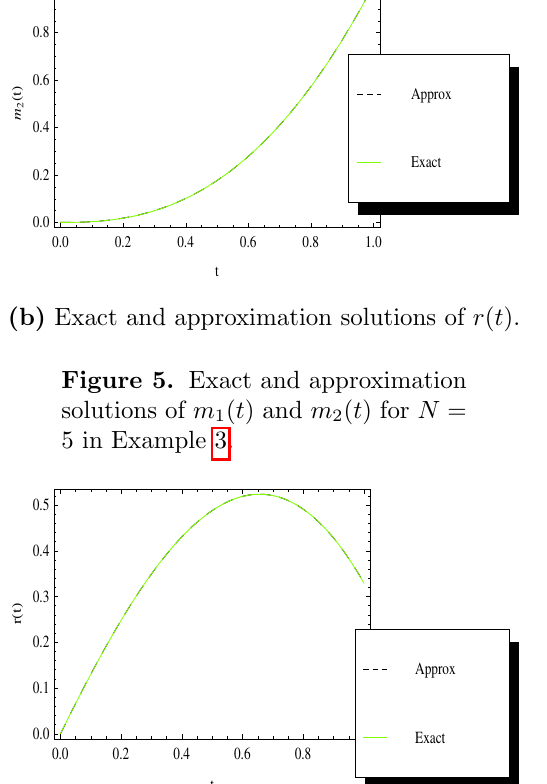
Figure 6. Exact and approximation solutions of r ( t ) for N = 5 in Exam- ple